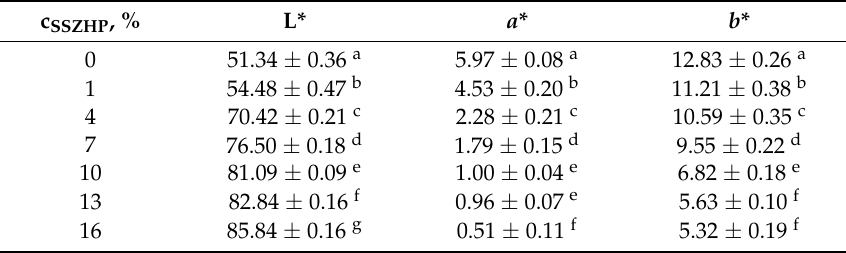
Table 3. The color of different composites before immersion.